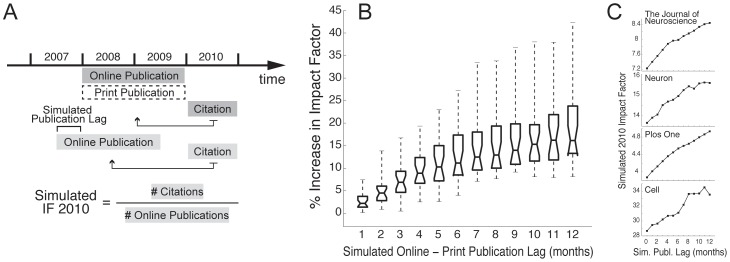
Journal impact factors positively correlate with the duration of online-to-print publication lags.(A) Schematic depiction of the estimation of 2010 impact factors for simulated lags. To simulate the effect of online-to-print lags on journal impact factors, the number of citations in 2010 to articles published in a 2-year window, shifted from 2008–2009 by the length of the simulated lag, is divided by the number of articles published in that period. (B) Percentage increase in impact factors as a function of the duration of simulated publication lags (left). This result was obtained by simulating online-to-print lags in 25 journals with negligible publication lags (<1 month). Boxes and whiskers represent percentiles as in Figure 1B. (C) Individual examples of the positive relation between a journal impact factor and the duration of the publication lag for 4 journals with negligible or nonexistent lags.